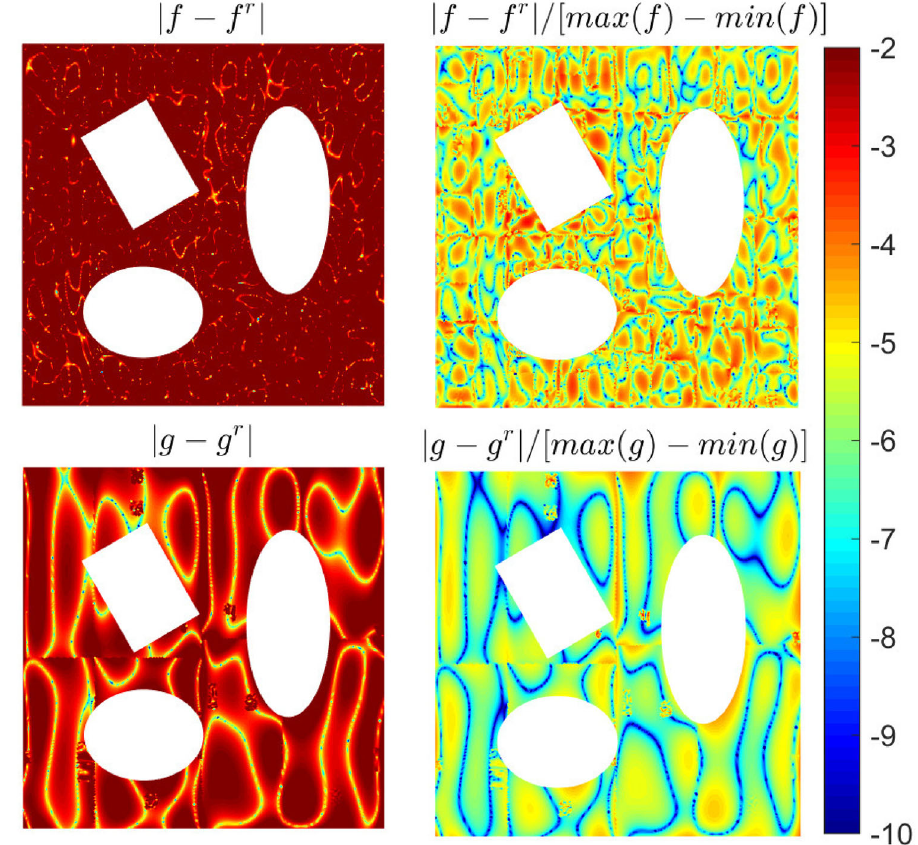
Fig. 5 Plots showing the local reconstruction errors for the fields f and g plotted in Fig. 4, as indicated. The right column shows the local errors in the left column normalized by the difference between the maximum and minimum